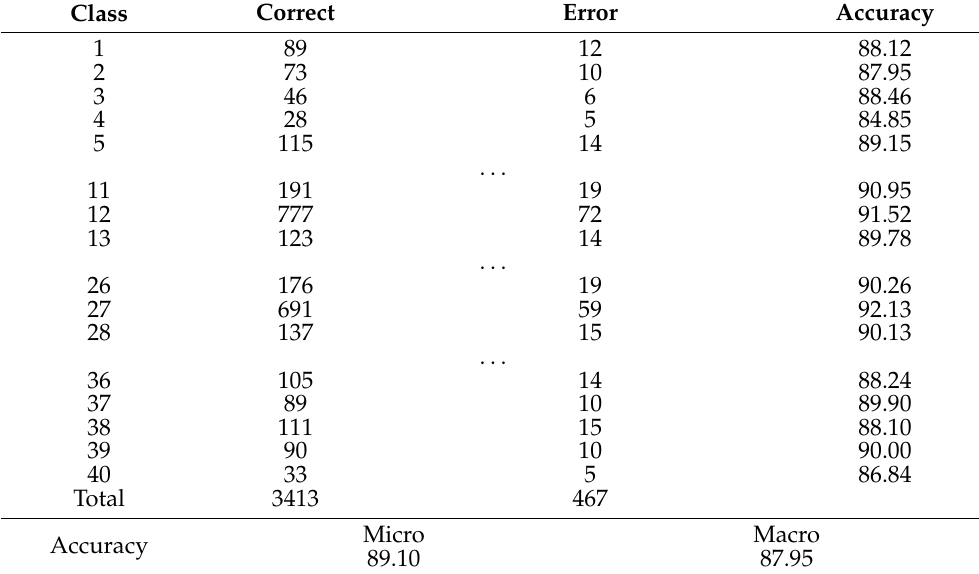
Table 4. Performance for each label measured in Task 2 of applied article